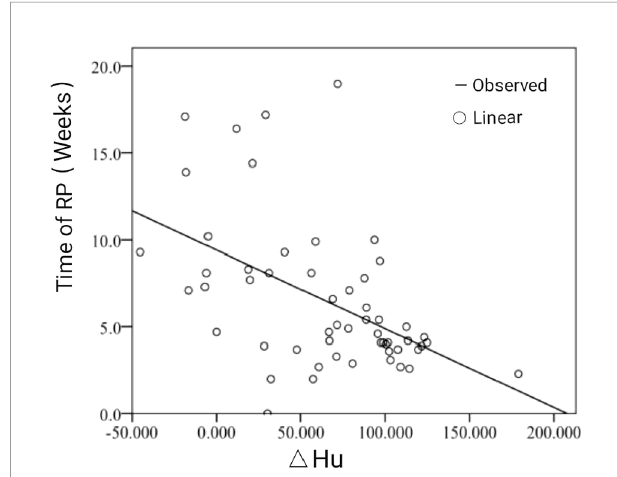
FIGURE 3 | The linear fi tting graph of RP occurrence time (y) and D Hu